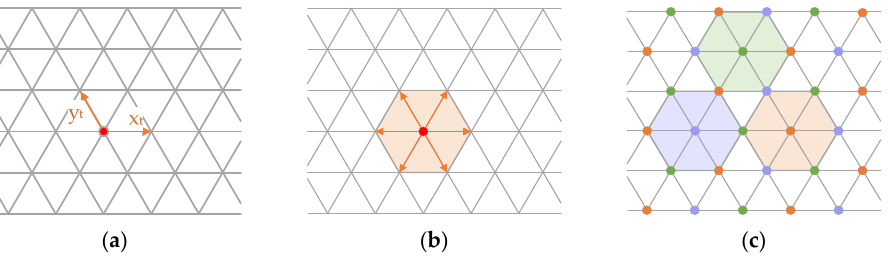
Figure 19. Triangular grid to hexagonal grid. ( a ) Triangular grid, its origin and coordinate system; ( b ) Vectors chosen to aggregate a hexagonal cell in triangular grid;( c ) There are three possibilities to choose the origin of the aggregation conversion illustrated by salmon, green and blue points.